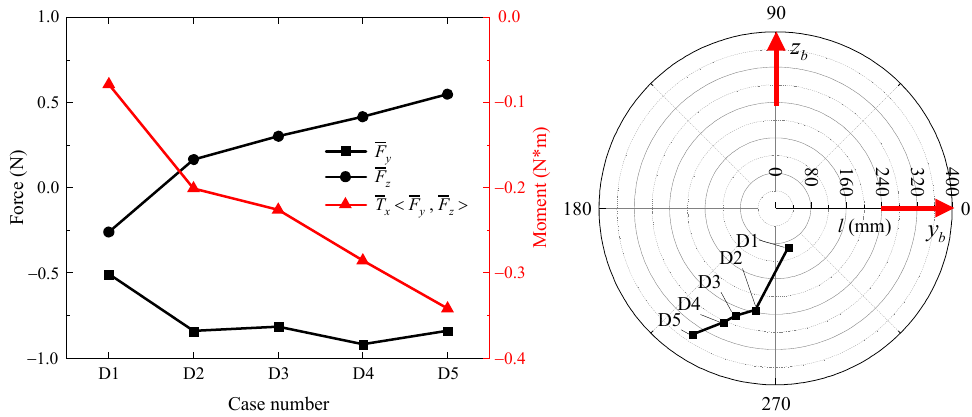
Figure 13. Hydrodynamic performance and equivalent point variation in Case